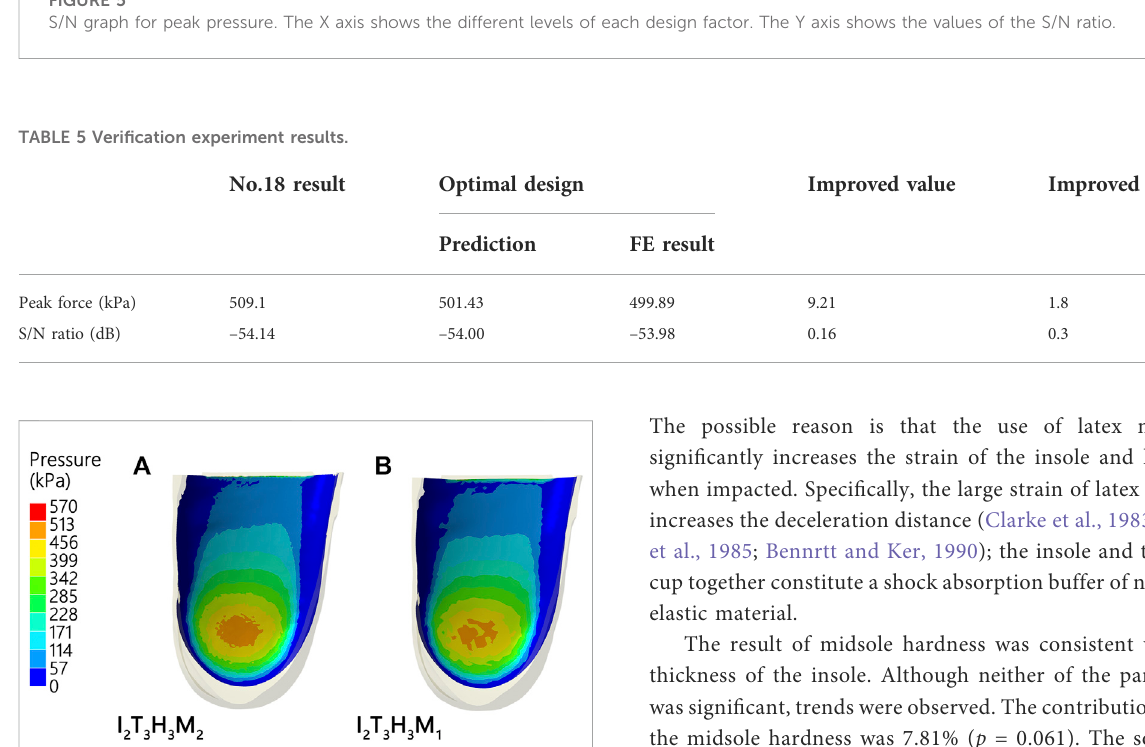
FIGURE 6 Veri fi cation experiment. (A) . No. 18 result and (B) . optimum